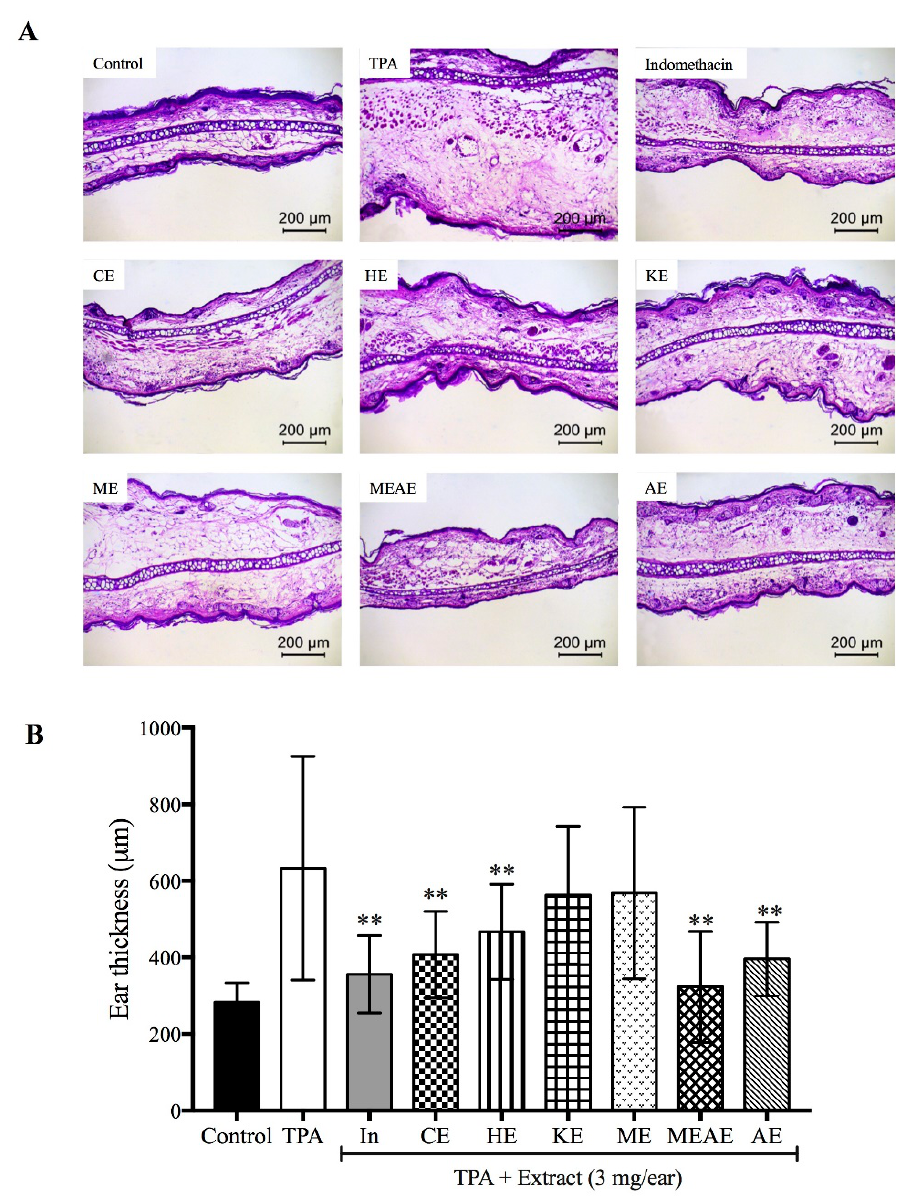
Figure 6. Histological features of mice ear tissue ( A ) stained with hematoxylin-eosin (200× magnification) on mice ear tissue thickness by the effect of different extracts of Acacia farnesiana pods on the TPA-induced ear edema model ( B ). TPA = 12- O -tetradecanoylphorbol acetate; In